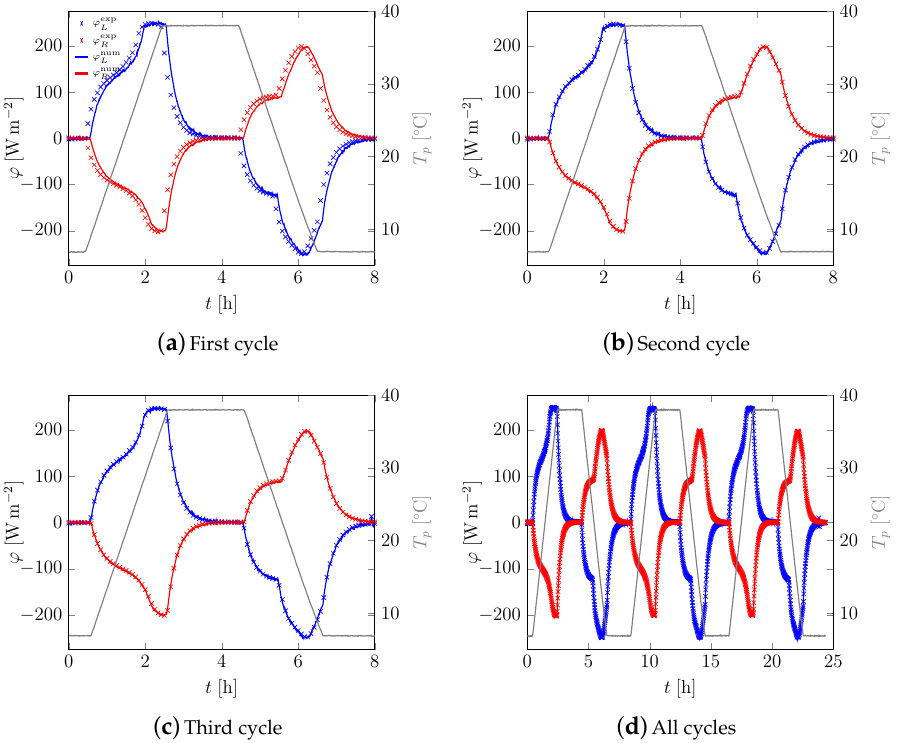
Figure A4. 19.2% w -PCM mortar: comparisons of the experimental fluxes with the numerical ones after identification for the 2 h heating/cooling ramp experiment.